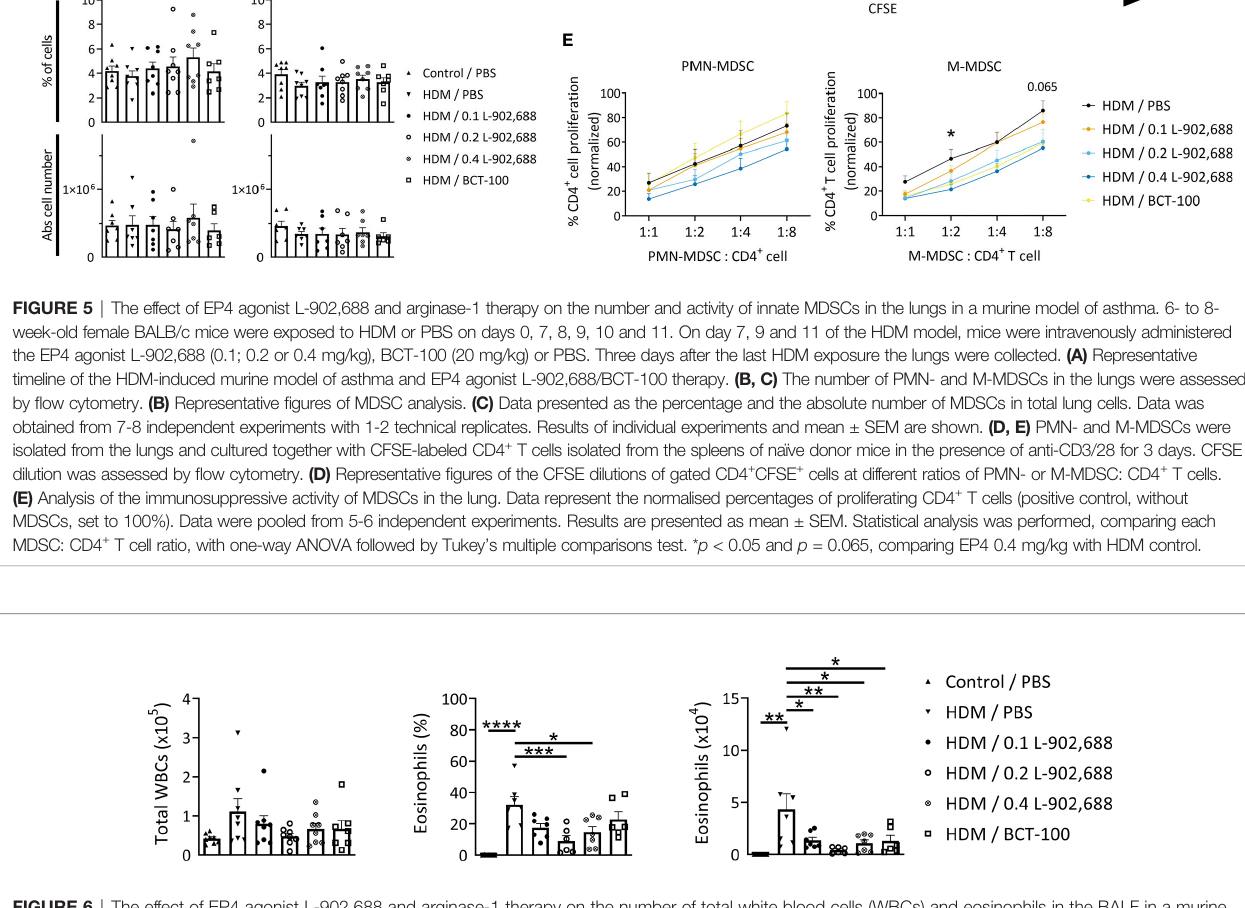
FIGURE 6 | The effect of EP4 agonist L-902,688 and arginase-1 therapy on the number of total white blood cells (WBCs) and eosinophils in the BALF in a murine model of asthma. 6- to 8-week-old female BALB/c mice were exposed to HDM or PBS on days 0, 7, 8, 9, 10 and 11. On day 7, 9 and 11 mice were intravenously administered the EP4 agonist L-902,688 (0.1; 0.2 or 0.4 mg/kg), BCT-100 (20 mg/kg) or PBS. Three days after the last HDM exposure the BALF was collected. Differential cell counts were performed on cytospin preparations stained according to Pappenheim. Total number of WBCs, the percentage of eosinophils and the number of eosinophils are shown. Data was obtained from 6-8 independent experiments. Results of individual experiments and mean ± SEM are shown. Statistical analysis was performed with one-way ANOVA followed by Tukey ’ s multiple comparisons test. * p < 0.05, ** p < 0.01, *** p < 0.001, **** p < 0.0001.